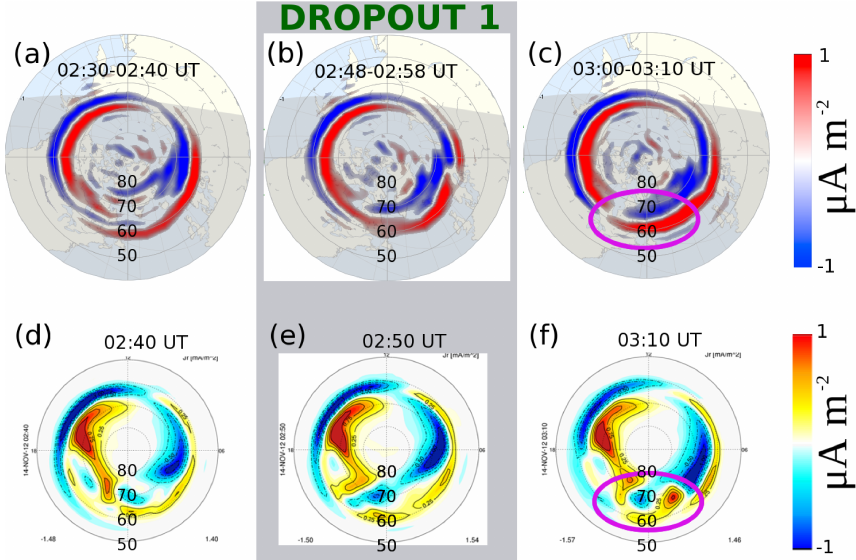
Figure 3. AMPERE-derived Birkeland currents and model Birkeland currents sampled to reflect dynamics before, during, and after dropout 1. The Birkeland currents J r are calculated for the Northern Hemisphere. The units are µAm − 2 ; color scale ranges from − 1 to 1µAm − 2 . Noon is from the top of each panel, with dawn being from the right side and dusk from the left side. The grey rectangle denotes the panels corresponding to the dropout 1 interval from Fig. 1. The injection signature is denoted by the magenta